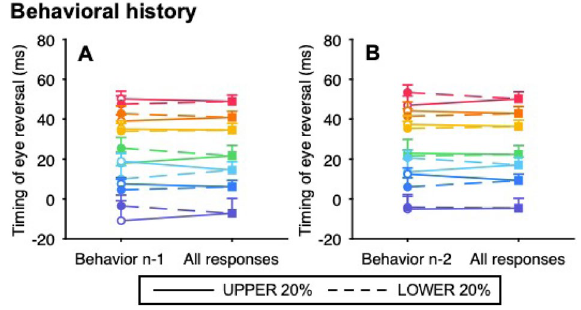
Figure 4. Effects of behavioral history on the timing of eye reversal in the predictable condition. The timing of eye reversal was ranked in ascending order at each target velocity, with the top 20% classified as “UPPER” and the bottom 20% classified as “LOWER”. Then, trials were sorted based on the classification of the n-1 ( A ) or n-2 trial ( B ). The left node shows the mean timing of eye reversal sorted by the classification, and the right node shows the mean of both trials. In the left node, the open symbols and solid lines represent the trials preceded by a response from the UPPER trials, and the filled symbols and dashed lines represent the trials preceded by a response from the LOWER trials. The color of symbols and lines correspond to the seven target velocities (same as in Fig. 1A). Error bars indicate 1 SEM.